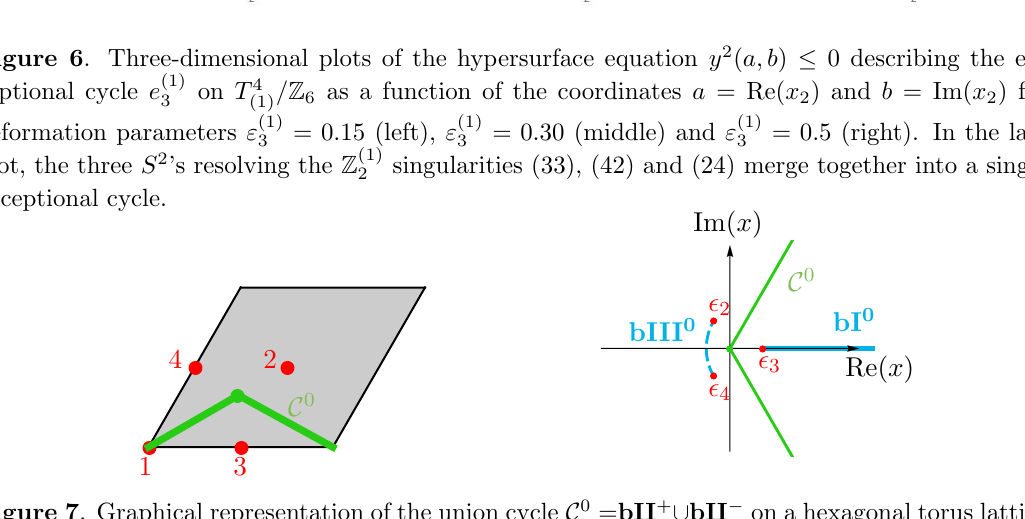
Figure 6 . Three-dimensional plots of the hypersurface equation y 2 ( a; b ) (cid:20) 0 describing the ex- ceptional cycle e (1) 3